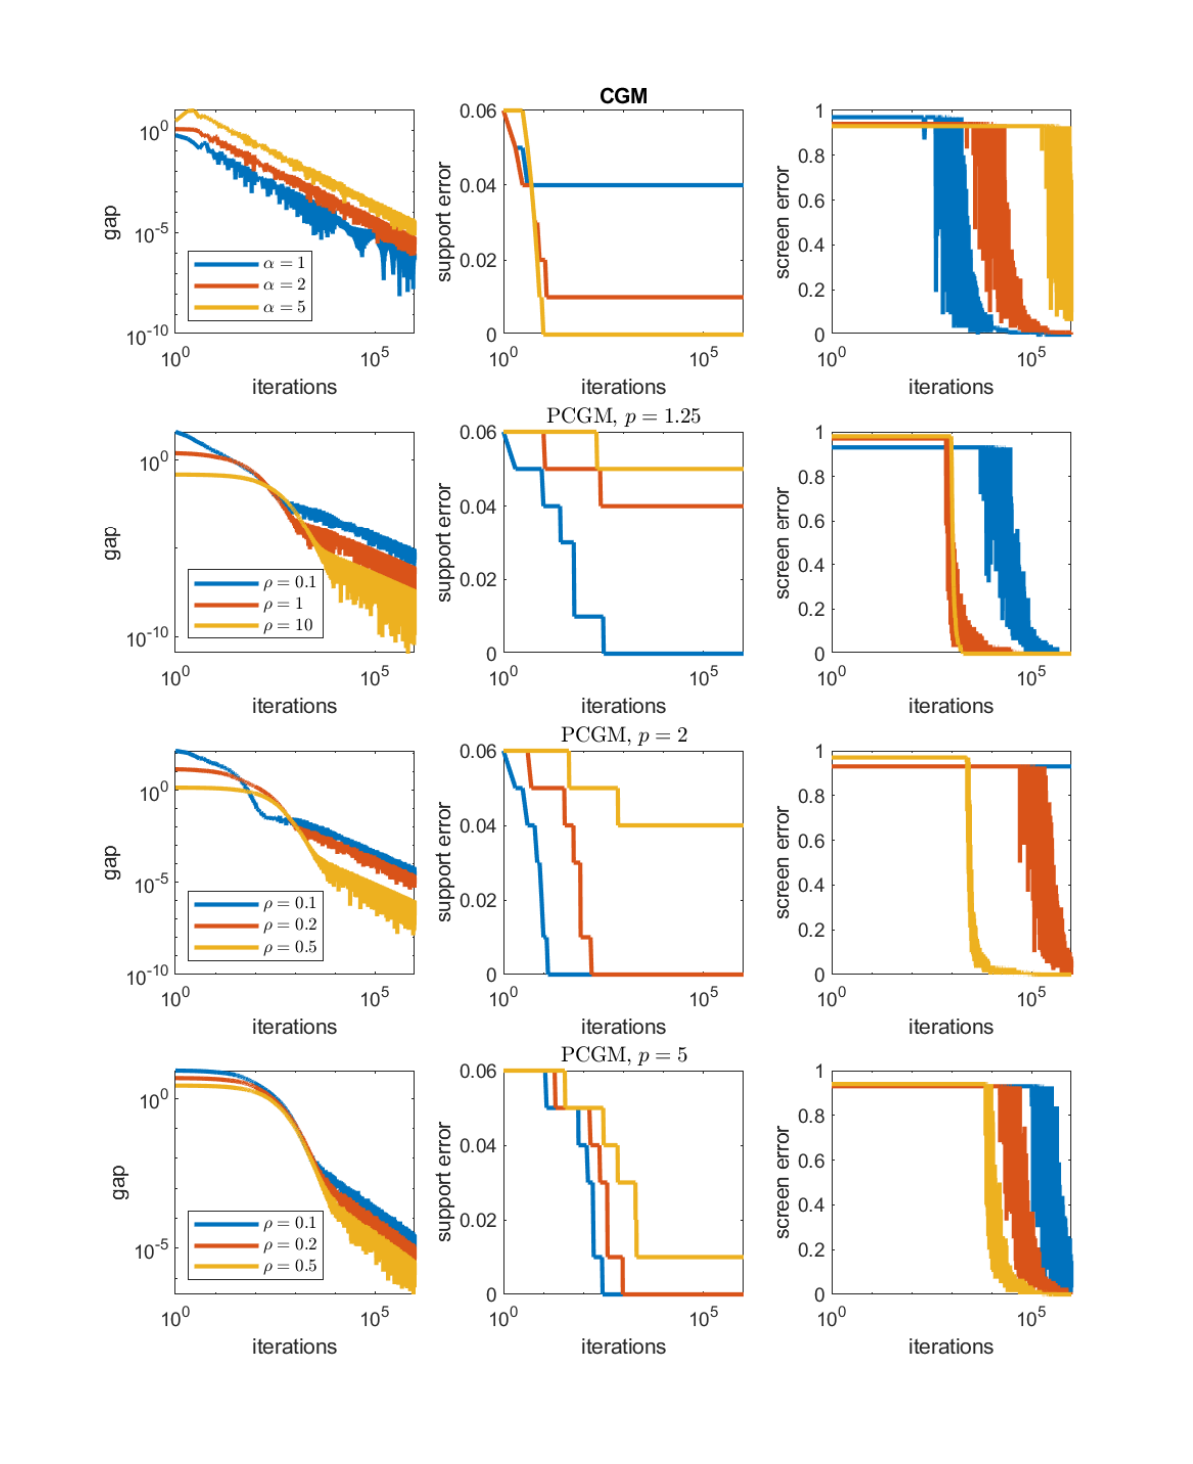
Figure 2 Small sensing experiment, CGM and P-CGM. The first row shows CGM, with φ ( s ) = ι s<α . The next three rows show P-CGM where φ ( s ) = ρ corresponding optimal ρ . For the P-CGM experiments, we also used an iteration offset of t 0 = 1000. Offset was not needed for CGM ( t 0 =